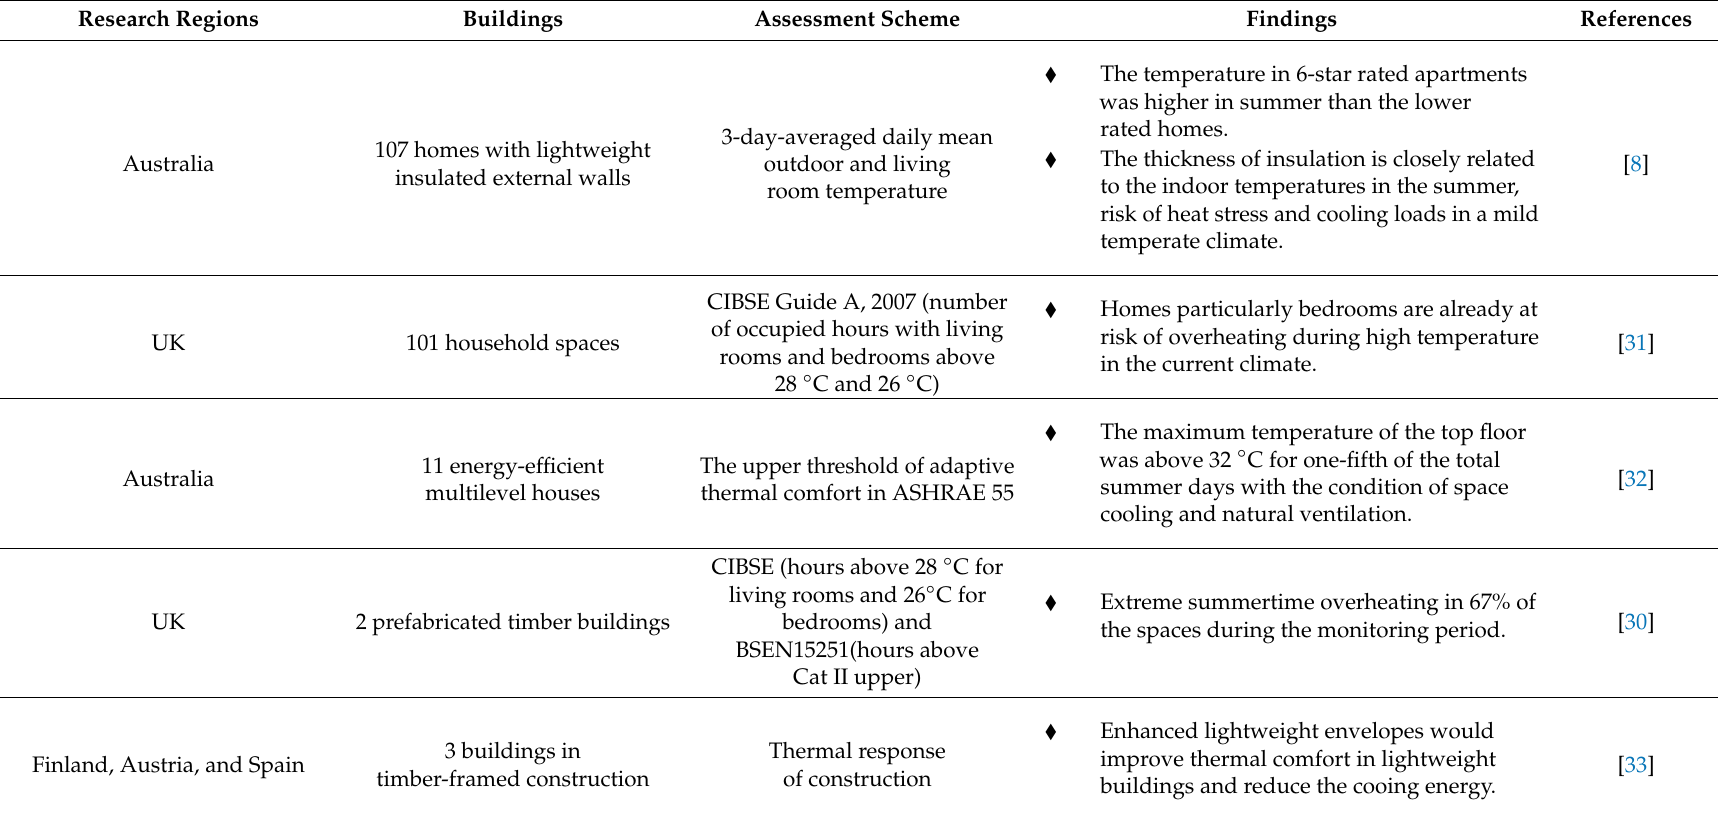
Table 1. Summary of results from overheating investigations in residential